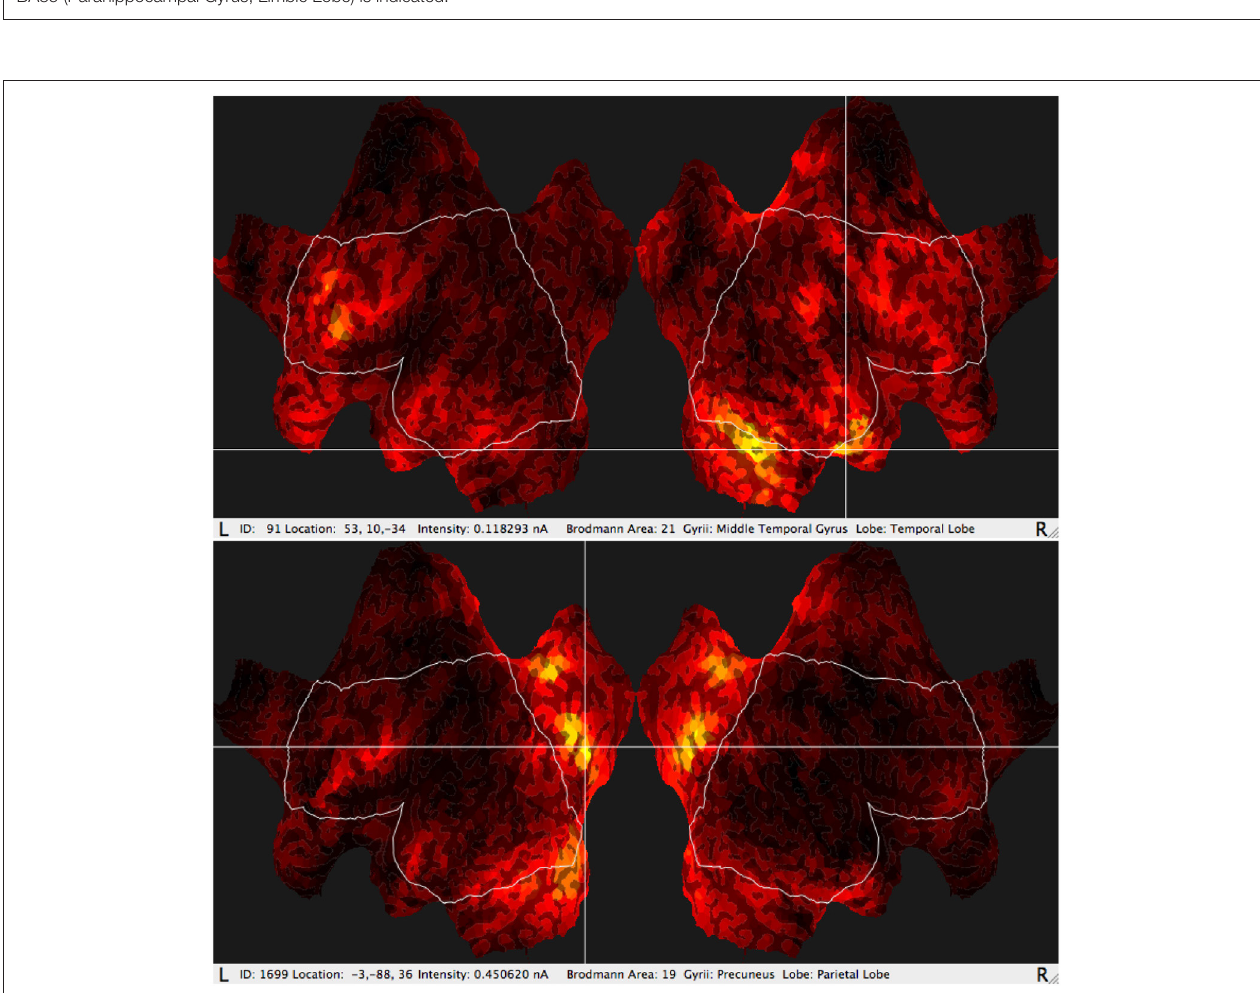
Frontiers in Neuroinformatics | www.frontiersin.org